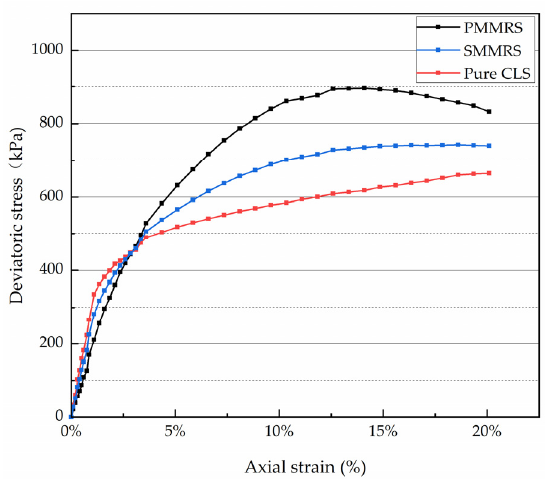
Figure 5. Shear response of specimens at confining pressure of 100 kPa.